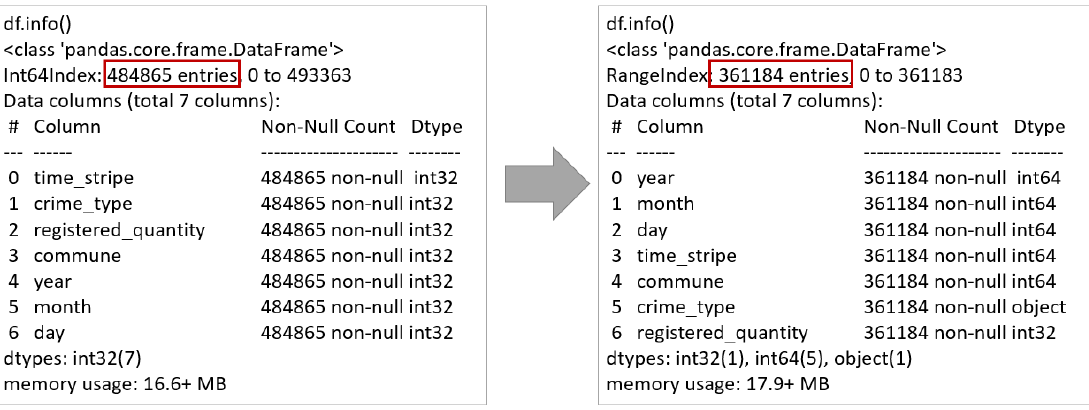
Figure A3. Data frame before and after the consolidation process Source Own elaboration.